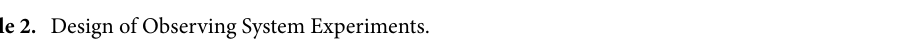
Table 2. Design of Observing System